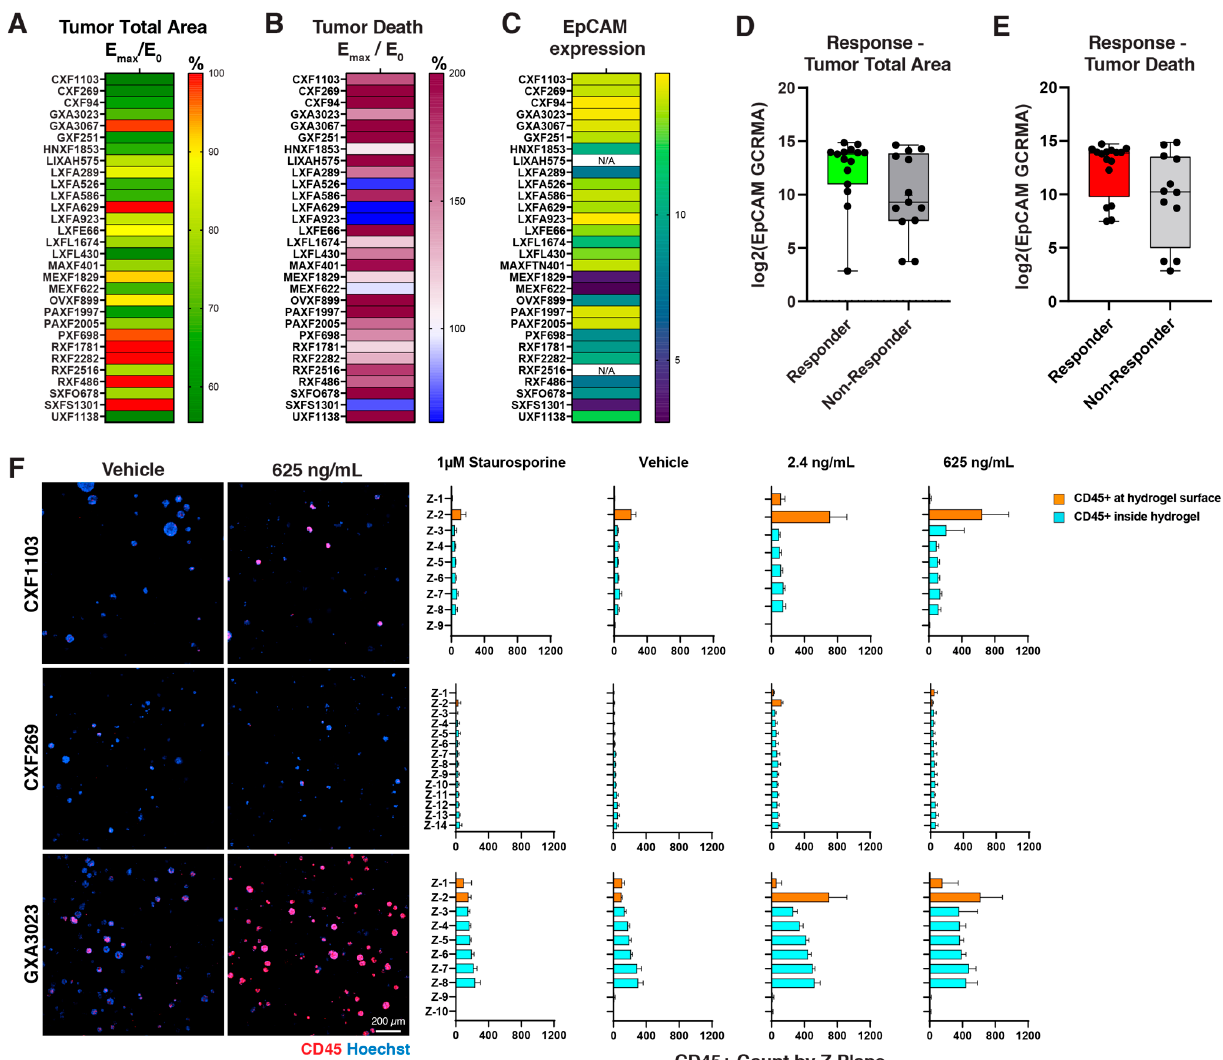
Figure 4. Solitomab immunotherapy screening of Tumor Panel: Endpoint analysis of Solitomab- treated 3D tumor models with PDX, HDF, and PBMCs in a 6-dose format. ( A ) Heat map showing the relative response rates of the 30 in vitro models—calculated values for E max /E 0 for both % tumor area reduction and ( B ) % cell death increase (right). ( C ) Heat map of EpCAM expression (where available) for the 30 Panel; comparison of EpCAM gene expression between the non-responder and responder lines for ( D ) tumor total area and ( E ) tumor death. ( F ) Representative images of CD45 immunofluorescence staining (red) for immune cells in three EpCAM+ high-expression models— CXF1103 (colon), CXF269 (colon) and GXA3067 (gastric), and subsequent Z-plane analysis of CD45+